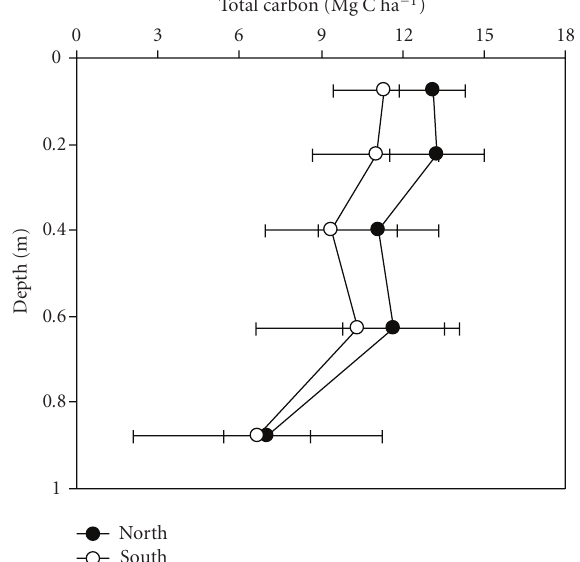
Figure 3: Total soil carbon content across depths prior to the tillage operations. Bars indicate the standard deviation of the mean.